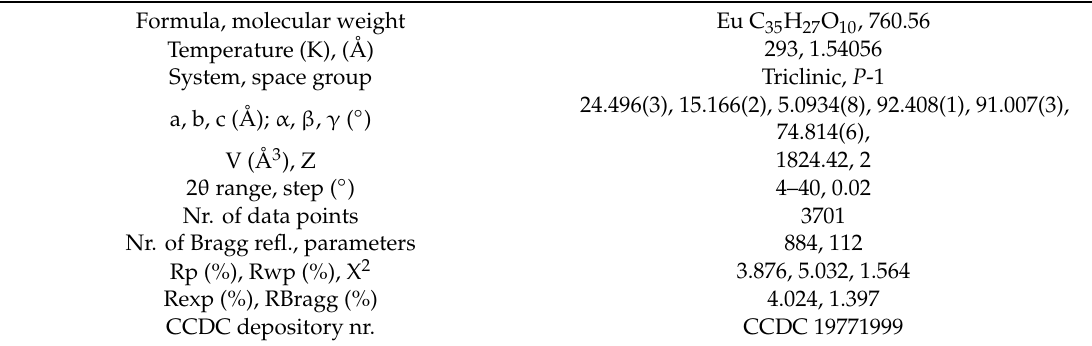
Table 3. Crystal data, Rietveld refinement parameters and Cambridge Crystallographic Data Center